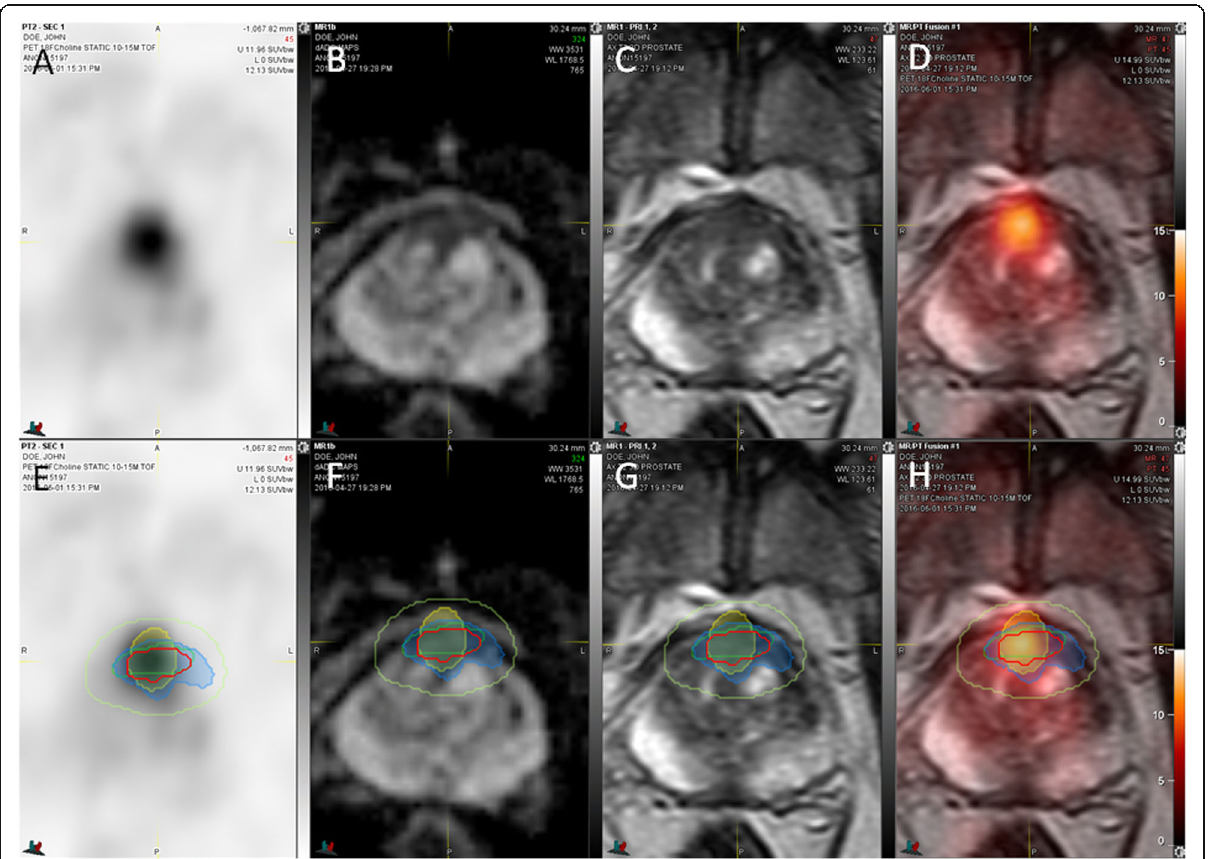
Fig. 5 Tumor segmentation results. Registered transaxial 18 F-choline PET ( a ), ADC ( b ), T2W MRI ( c ), and 18 F-choline fusion PET/MRI ( d ) are shown (SUV range 0 – 15). Contours of a Gleason 3+4 prostate cancer are displayed on corresponding slices obtained from registered histology (blue line and contour shadow) and compared to registrations from two human readers (red and green line and a contour obtained from 8 F-choline PET (yellow)) using a semiautomatic thresholding method ( e – h ). A contour combining these three segmentations with an added safety margin of 5 mm (lime line) completely covers the histological tumor